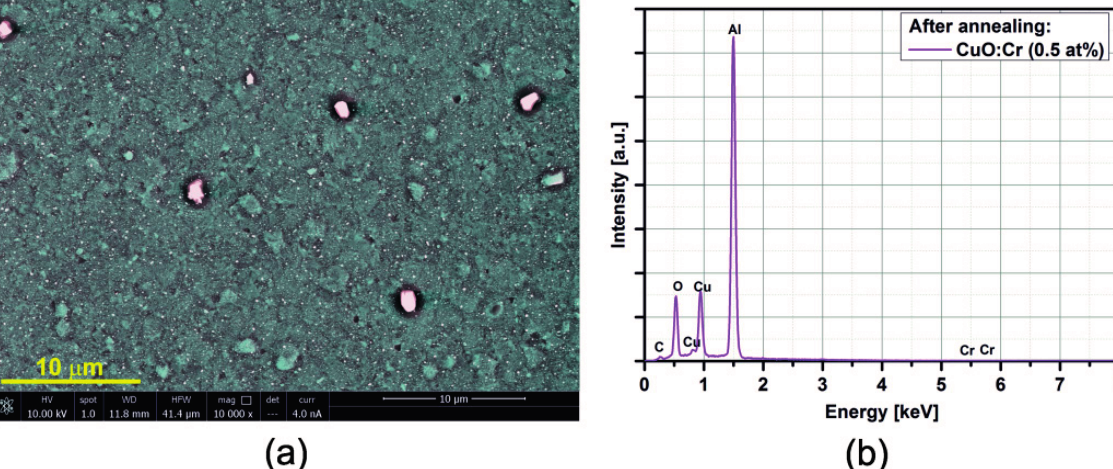
Figure 6. ( a ) SEM image; ( b ) EDX distribution of the Au:CuO-based sensor (Au: 3.0at%).